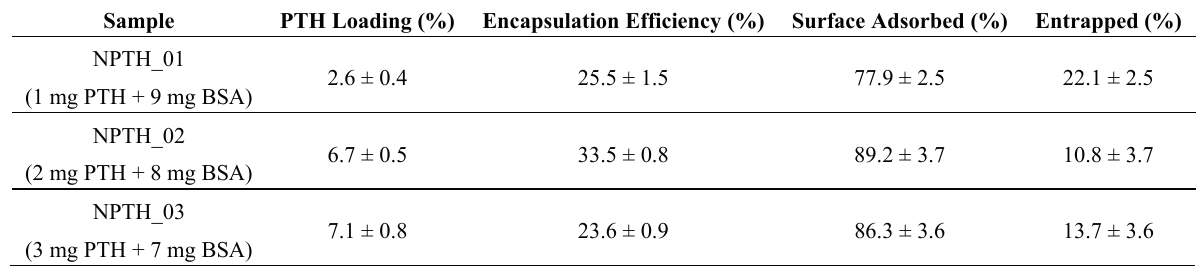
Table 1. Amount of parathyroid hormone (PTH) detected in various formulations.